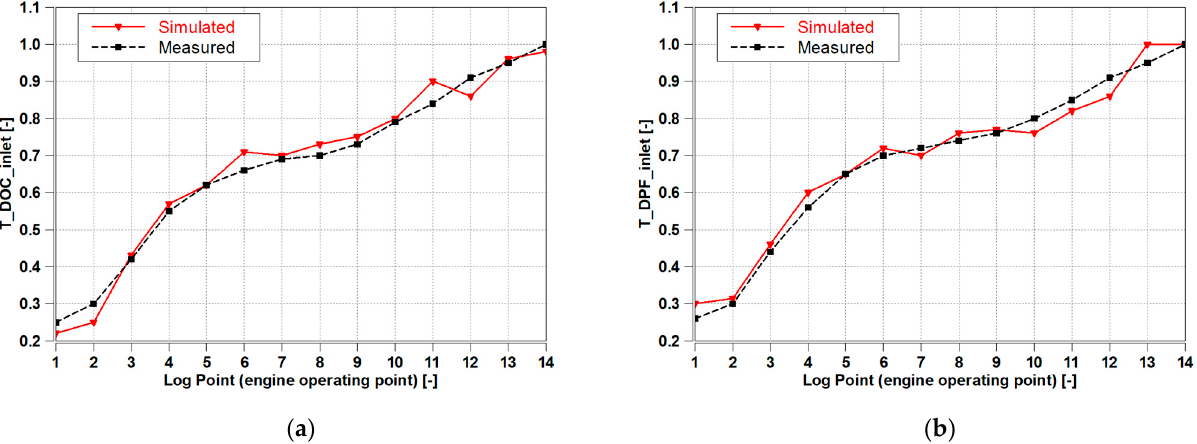
Figure 25. ( a ) Simulated (red) vs measured (black) DOC inlet temperature (normalized with respect to the maximum value reached in the test); ( b ) Simulated (red) vs measured (black) DPF inlet temperature (normalized with respect to the maximum value reached in the test).